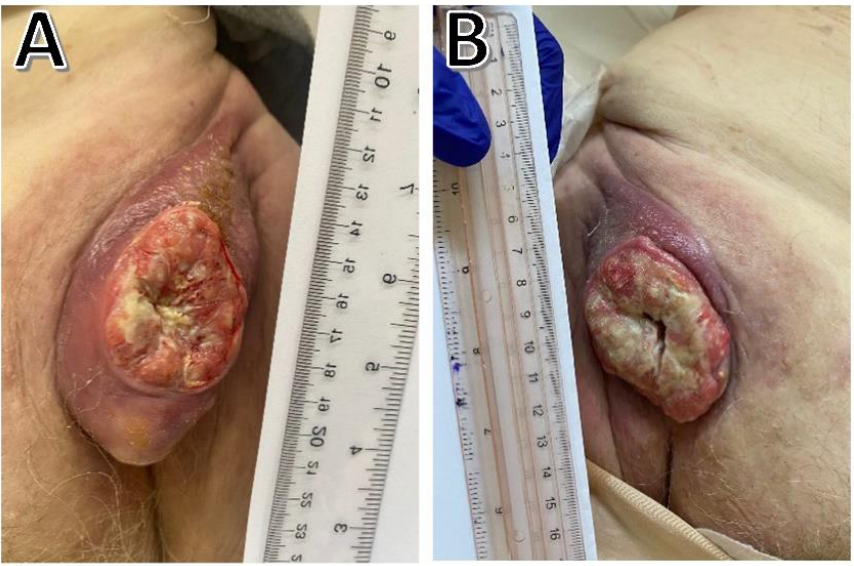
Figure 3. ( A ) Before treatment; ( B ) after 3 administrations of cemiplimab (6